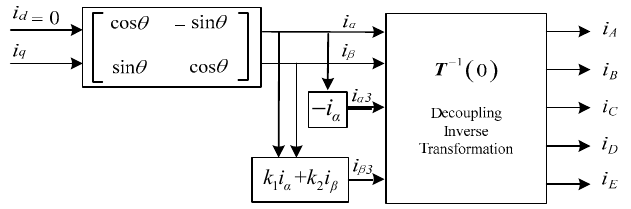
Figure 4. Fault-tolerant current based on fault-tolerant control law.